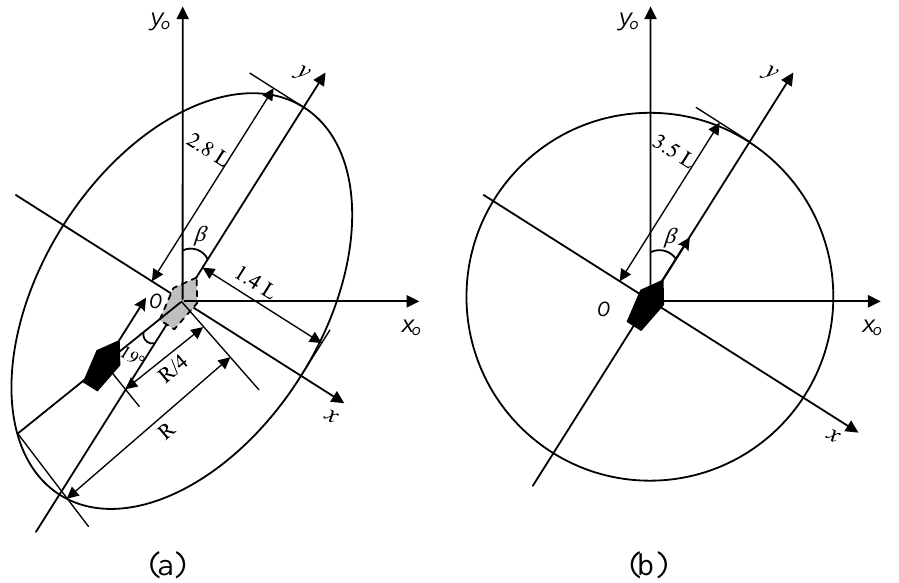
Figure 3. Inland-ship domain for: ( a ) dynamic obstacles, ( b ) static obstacles.